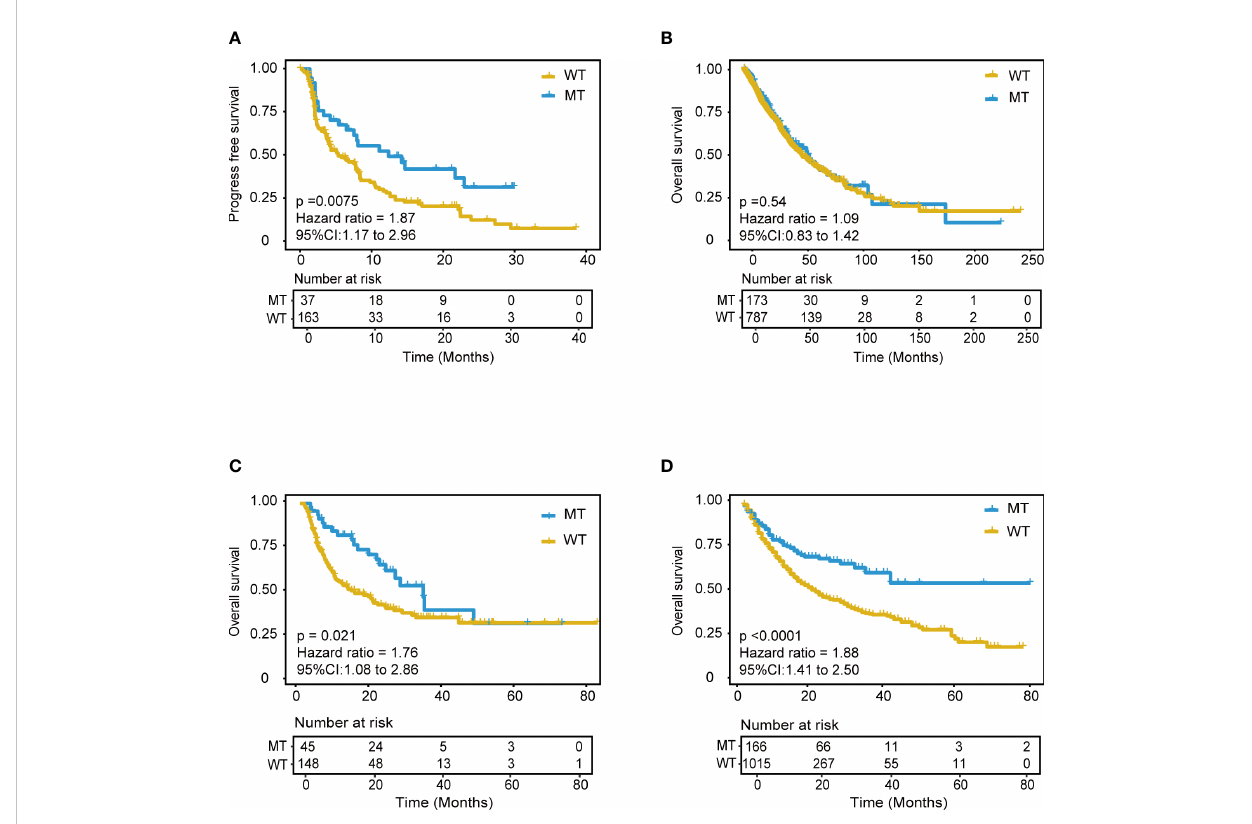
FIGURE 5 Validation of the mutation-based model in validation cohorts. (A) Kaplan-Meier survival analysis for PFS between MT group and WT group in the validation cohort 1. (B) Kaplan-Meier survival analysis for OS between MT group and WT group in the non-immunotherapy TCGA cohorts. Extension validation of the model in the two independent pan-cancer cohorts. (C) Validation cohort 2 and (D) Validation cohort 3. OS, overall survival; PFS, progression-free